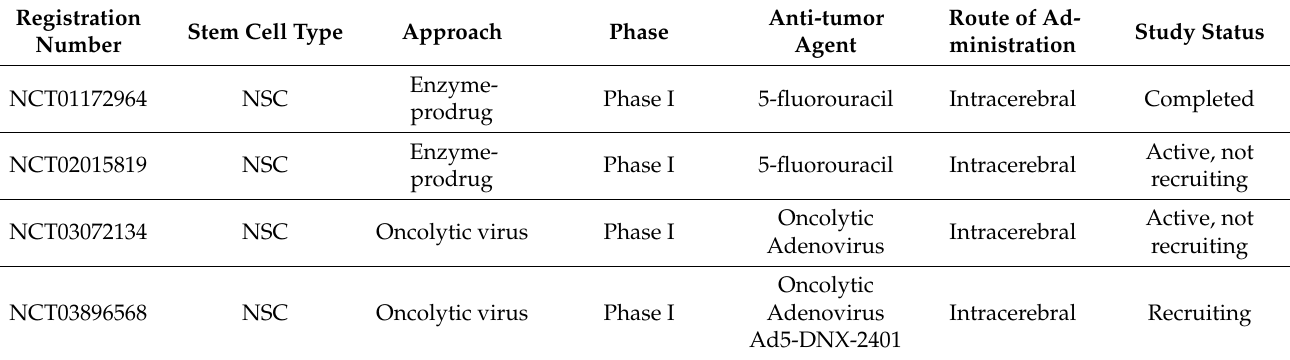
Table 1. Active clinical trials evaluating NSC-based therapy in glioma